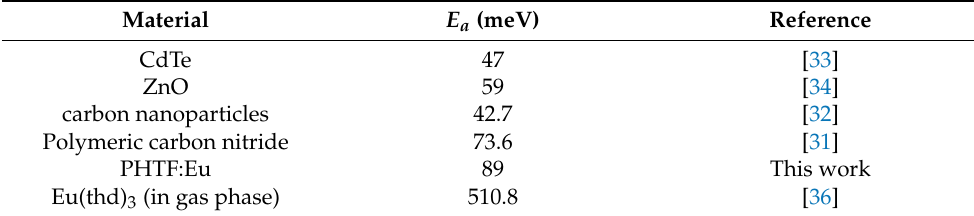
Table 2. Activation energies of various emitting